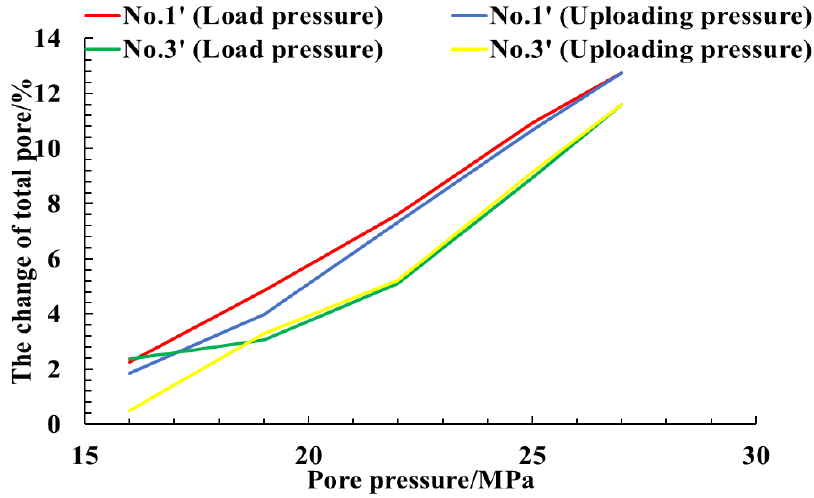
Figure 8. The change rate of total pore under different pore pressures of fractured samples.